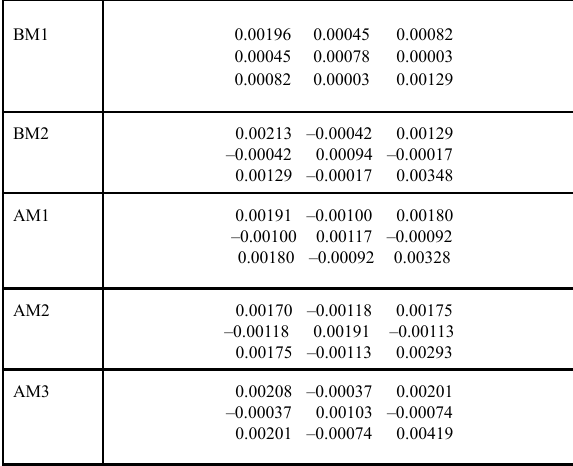
Table 2: Data modified from Gillan 1 . The variance-covariance matrix for vector h is shown for each data set collected. BM1: Data collected 30 minutes prior to instillation of Mydriacyl into the right eye of the subject, BM2: Data collected just prior to instillation, AM1: Data collected 15 minutes post instillation, AM2: Data collected 30 minutes post instillation and AM3: Data collected 60 minutes post instillation. All quantities have units